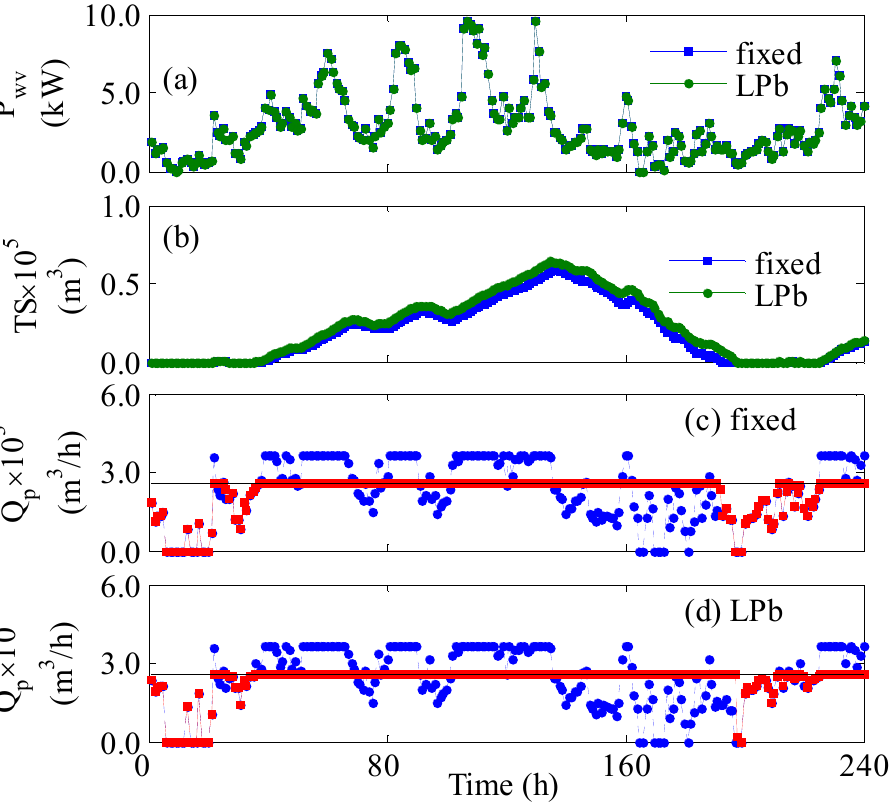
Figure 7. Plant dynamic response for 10 days under a shortage of turbines and vessels; ( a , b ) square marker: fixed, circle marker: LPb ; ( c , d ) solid line: Q s p ; blue circle: Q p ; red square: Q r p Table 3. Results of the instantaneous control for a one ‐ year operation.